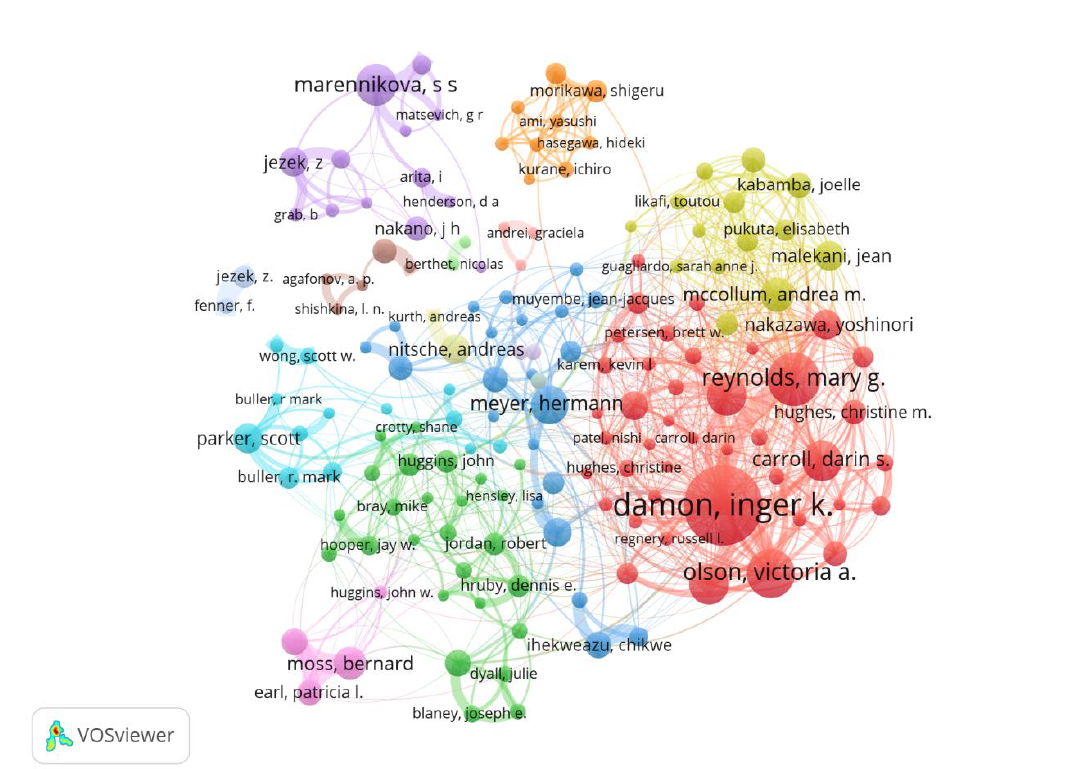
Figure 2. The co-occurrence map of authors in MPX